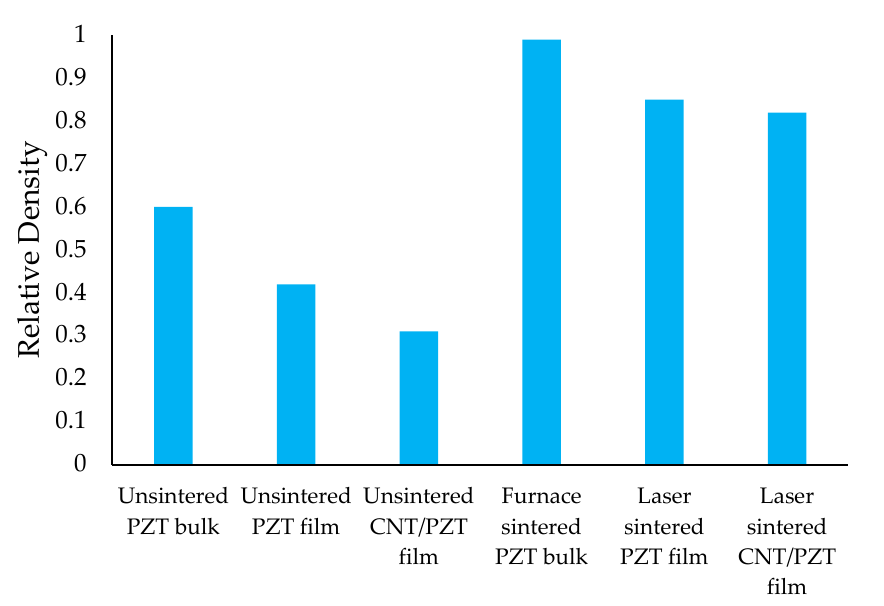
Figure 12. Relative density of the unsintered and sintered samples.